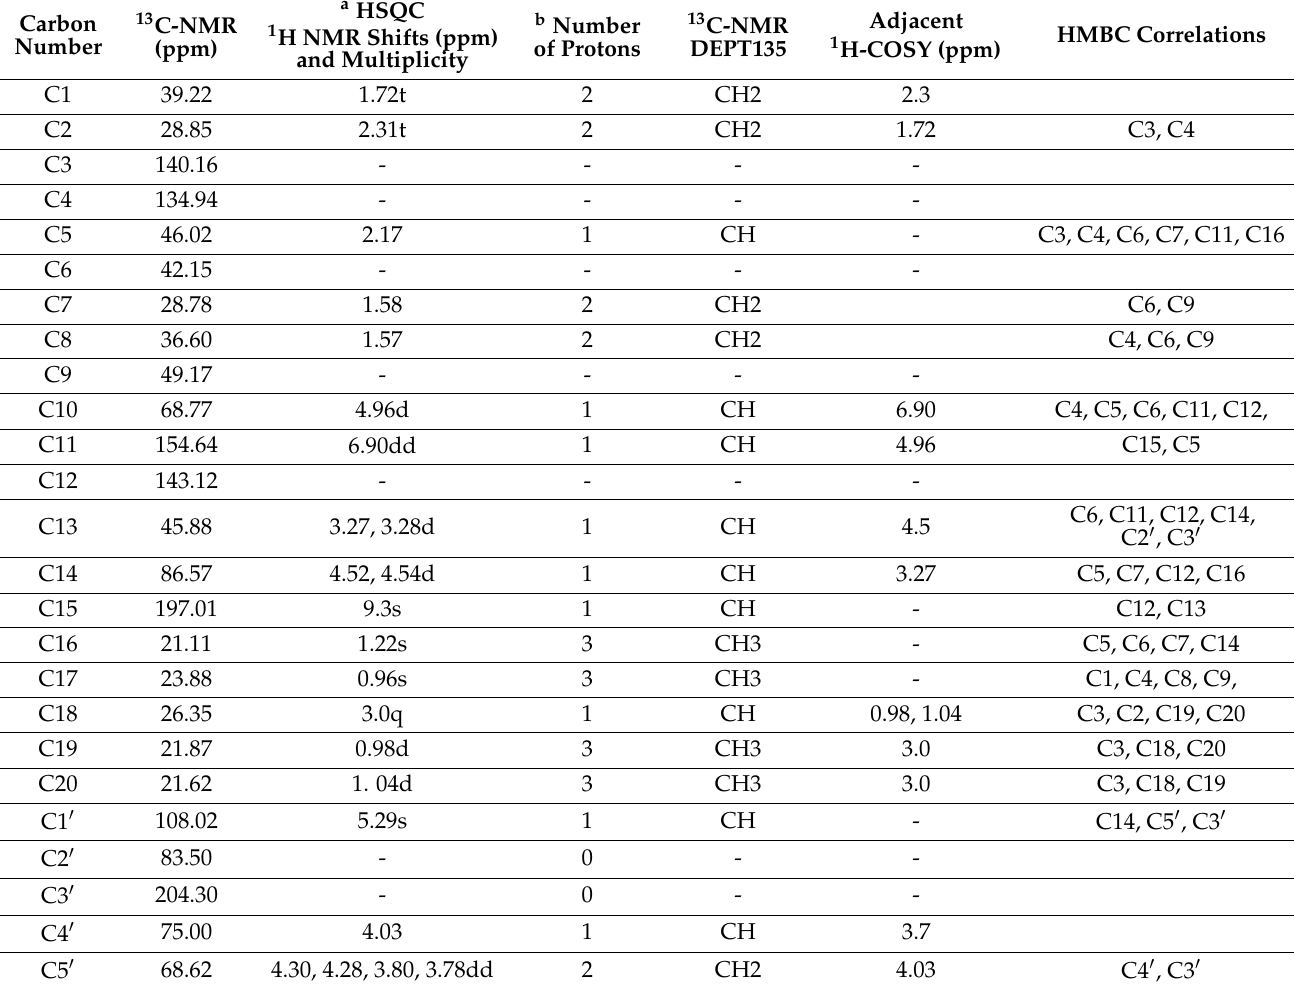
Table 1. Assignment of the signals in the one- and two-dimensional NMR spectra of the isolated active compound (striatal C). The 1 H- and 13 C-NMR spectra were measured at 600 MHz and coupling constants are in